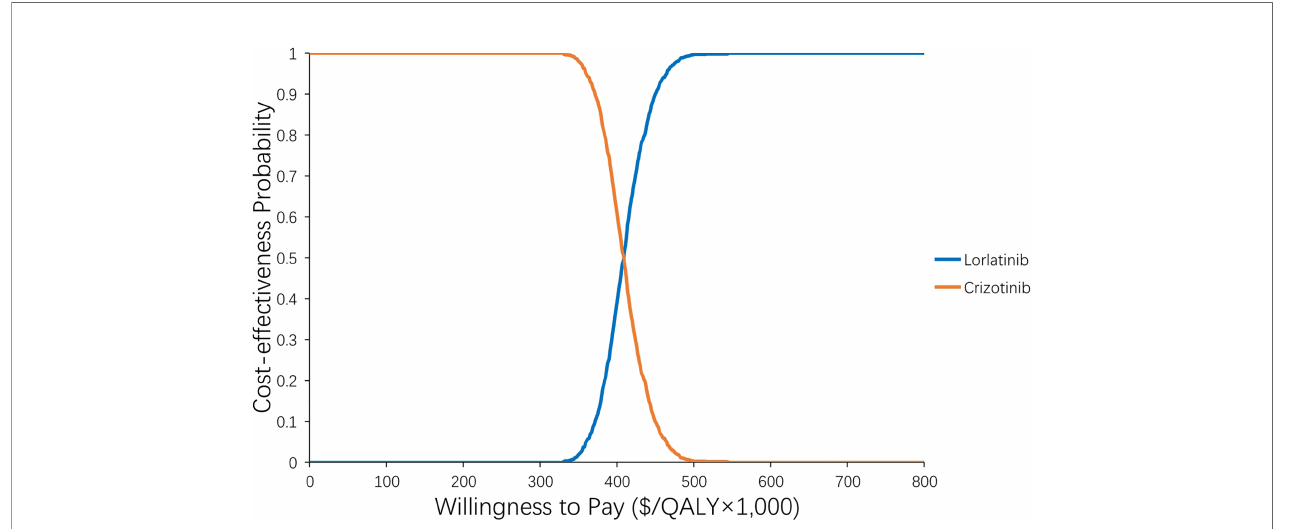
FIGURE 3 | Acceptability curve of the probability sensitivity analysis. The probability sensitivity analysis of the base case.